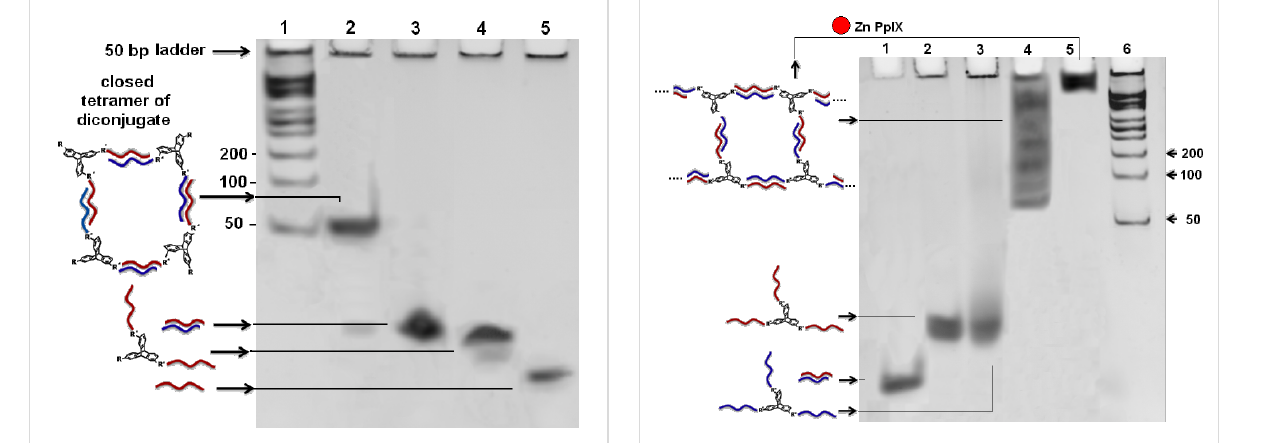
Figure 2: Native PAGE image (12%) of self-assembly of dicojugate DNA–TPA units with 2 μ M total ssDNA concentration. Lane 2 shows the assembly of DNA–TPA diconjugates from (S1) 2 –TPA and (S2) 2 –TPA.